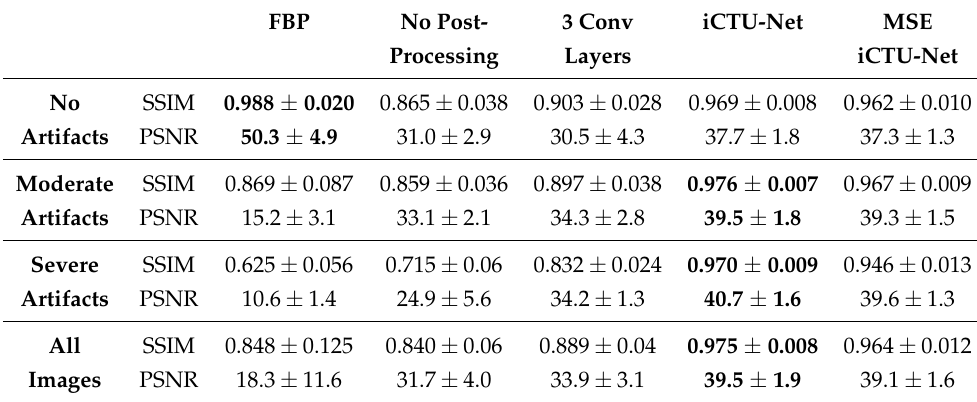
Table 1. SSIM and PSNR evaluation metrics for the ablation study. All networks are trained with pre-corrected NMAR sinograms and the SSIM loss, except for the MSE iCTU-Net, which is trained with the MSE loss. The best result for each metric is marked bold . FBP No Post- 3 Conv